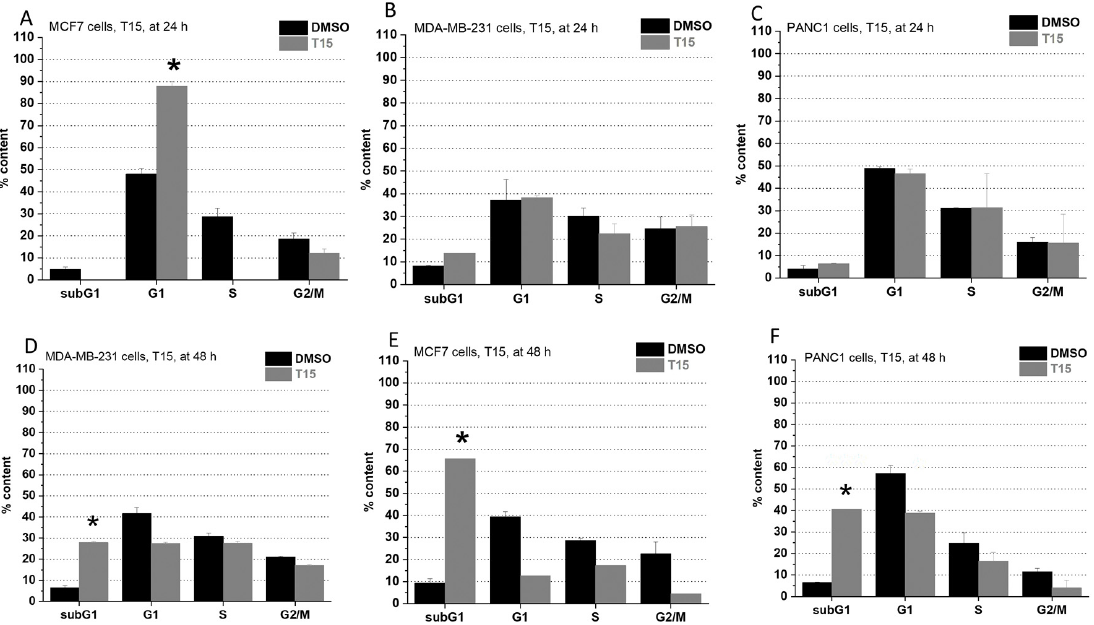
Figure 3. Impact of T15 on the cell cycle on MCF7 (( A ): at 24 h, ( D ): at 48 h), MDA-MB-231 (( B ): at 24 h, ( E ): at 48 h), and PANC1 cells (( C ): at 24 h, ( F ): at 48 h). Each cell line was treated with 25 µM. Each result represents the measurement of two parallel samples ( n = 2). Data are given as mean values ± standard deviation (SD). Asterisks mark the subpopulation, where the number of cells is significantly higher compared to the DMSO control, and a cell cycle arrest is seen ( p < 0.05: *, p < 0.001: ***) determined by the One-way ANOVA test followed by Fisher’s LSD post hoc test.